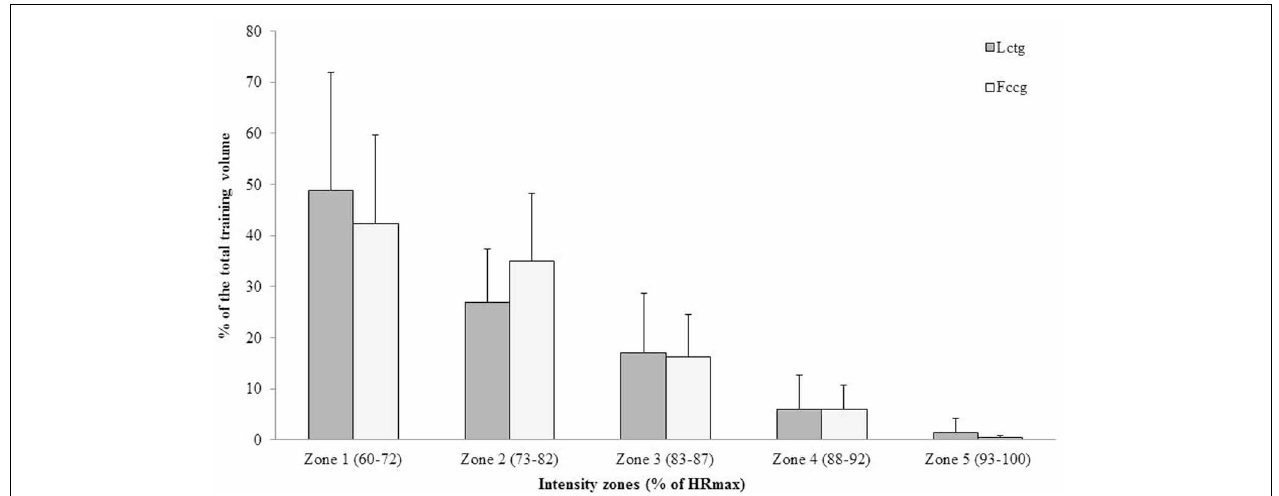
FIGURE 1 | Endurance training (mean ± SD ) in % of total training volume at different intensitie zones in the low cadence training group (Lctg) and in the freely chosen cadence group (Fccg) during the 12 weeks training intervention period. There was no significant differences between the groups.